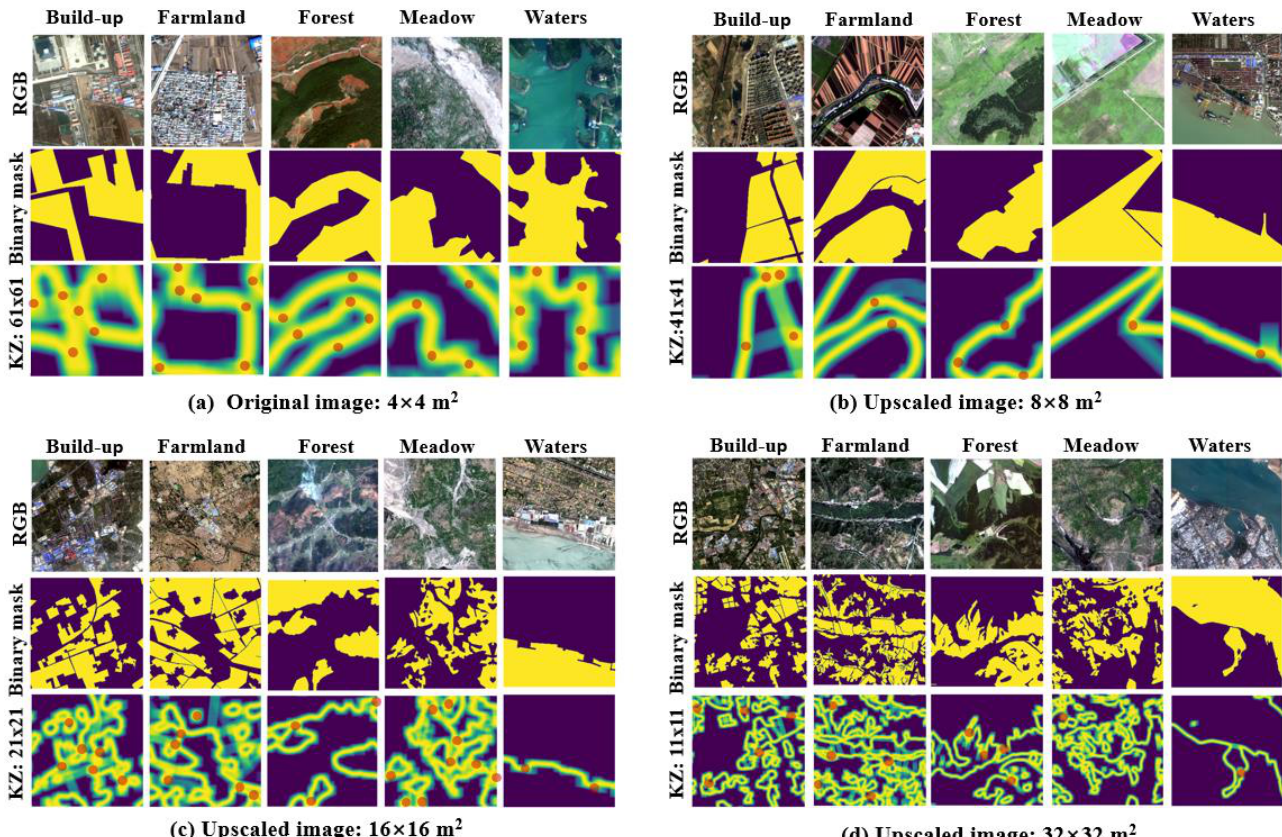
Figure 7. Quantification of entropy-based surface complexity by varying upscaling spatial scales (KZ: kernel size). The RGB images display true colors, while the binary mask appears in yellow to represent the target feature. In the KZ rows, a color gradient ranging from blue to yellow is used, where yellow represents higher complexity scores (light-red circle dot: hotspots of surface complexity).